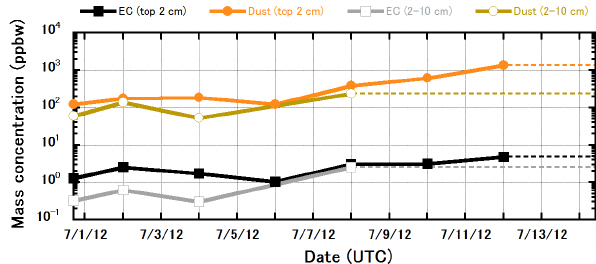
Figure 5. Measured mass concentrations of elemental carbon (EC) and dust in the top 2cm of snow layers and the subsurface (2–10cm) layers at the SIGMA-A site during the IOP. Dashed lines indicate periods when there were no